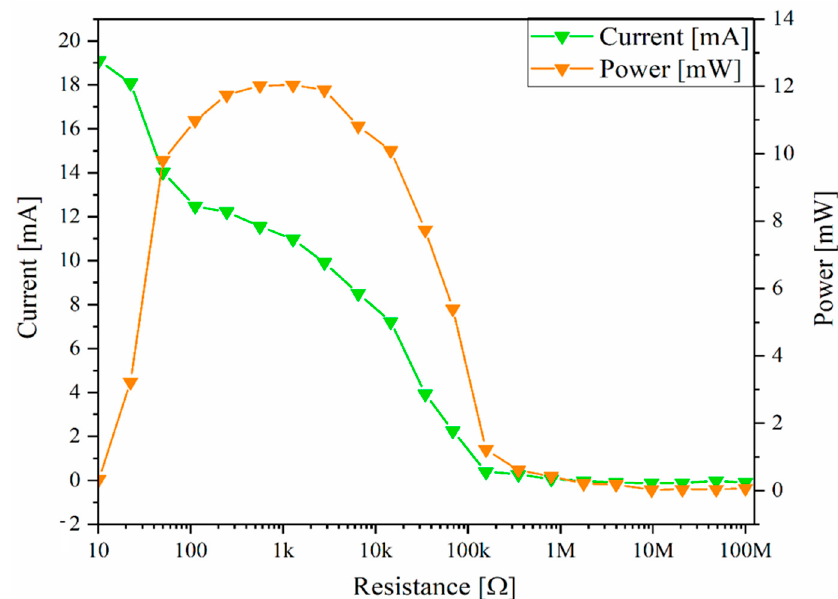
Figure 15. Maximum power output of the hybridized